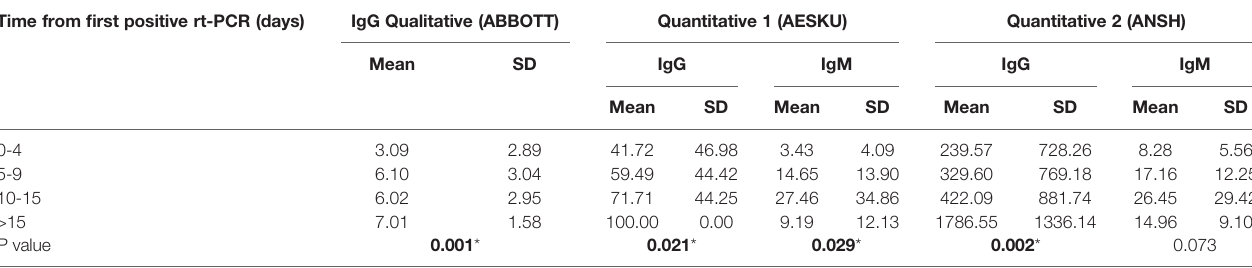
TABLE 4 | Progression over time of IgM and IgG levels by testing method (pooled data). Time from fi rst positive rt-PCR